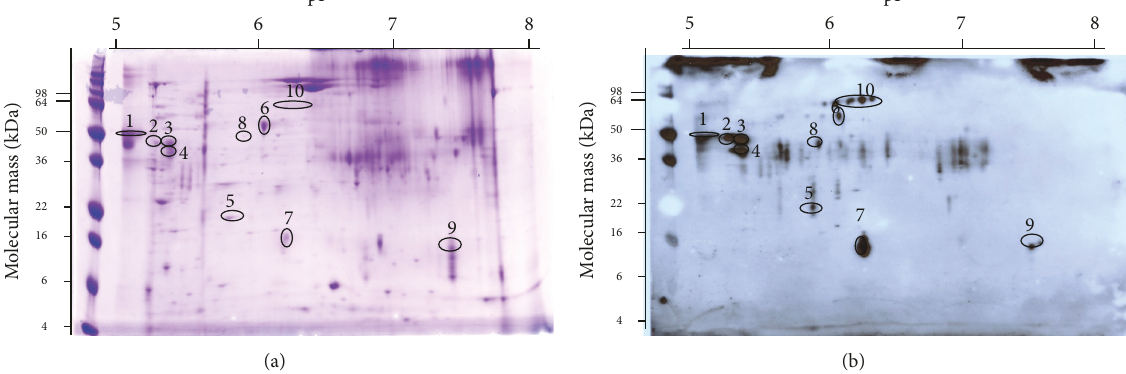
Figure 1: Identification of Tm16 by 2D gel electrophoresis on 8–16% Tris-HCl criterion gel. The first dimension was isoelectric focusing while the second dimension was SDS-PAGE. Ten independent protein spots were excised and sent for identification. Tm16 identified in spots 7 and 9. (a) Gel was stained with Coomassie brilliant blue. (b) Western blot of corresponding gel primary antibody was mouse ES immune sera and secondary antibody was anti-mouse IgG